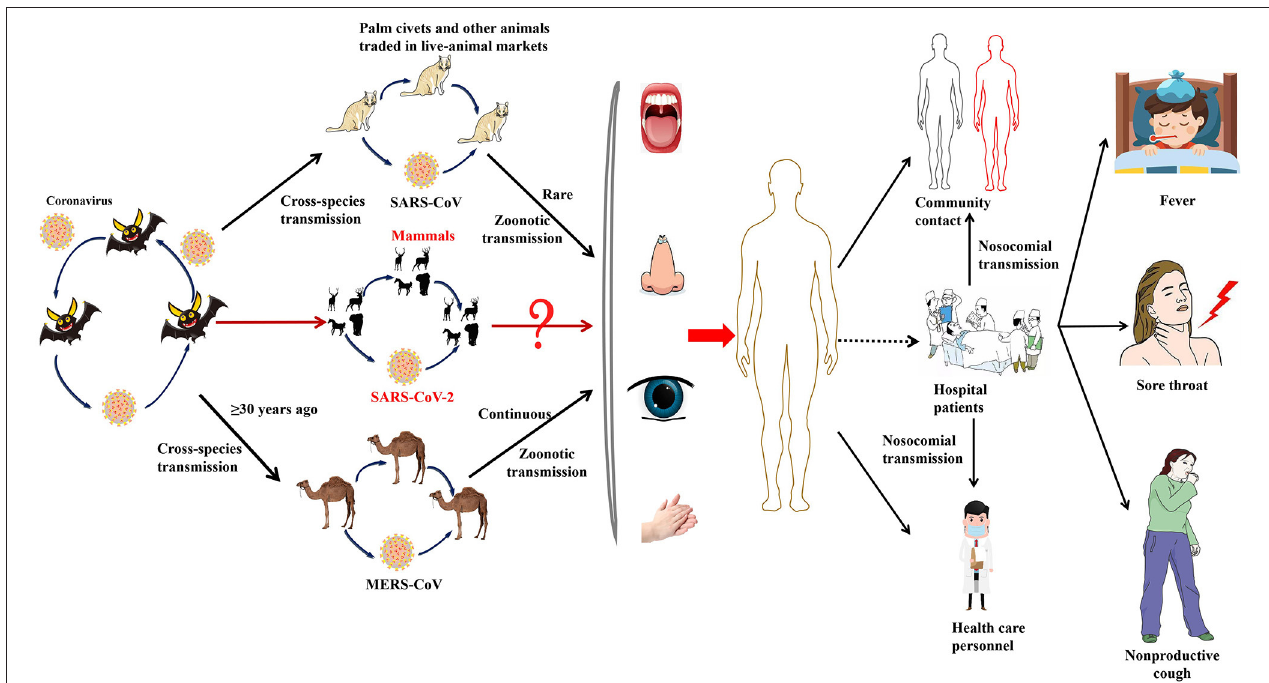
FIGURE 3 | The emergence of SARS-CoV-2, SARS-CoV, and MERS-CoV. Bats harbor a wide range of coronaviruses, including SARS-CoV-like and MERS-CoV-like viruses. SARS-CoV crossed the species barrier into masked palm civets and other animals in live-animal markets in China; genetic analysis suggests that this occurred in late 2002. Several people in close proximity to palm civets became infected with SARS-CoV. A MERS-CoV ancestral virus crossed the species barrier into dromedary camels; serological evidence suggests that this happened more than 30 years ago. Abundant circulation of MERS-CoV in dromedary camels results in frequent zoonotic transmission of this virus. SARS-CoV-2, SARS-CoV, and MERS-CoV spread between humans. However, the main mode of transmission of COVID-19 is